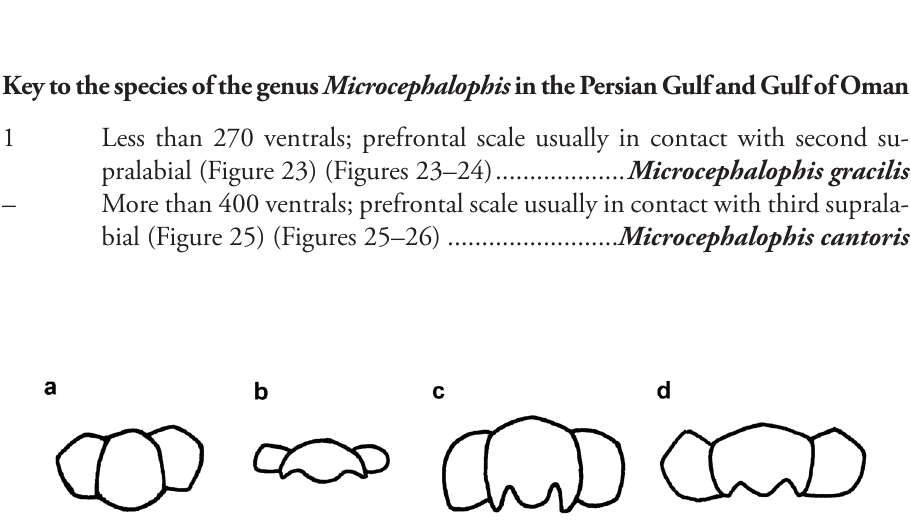
Figure 2. Various shapes of rostrals of sea snakes of the genus Hydrophis in the Persian Gulf and Gulf of Oman: a tip of rostral decurved and pointed (beaked-shaped) b and c tip of rostral tridentate d tip of rostral unidentate.